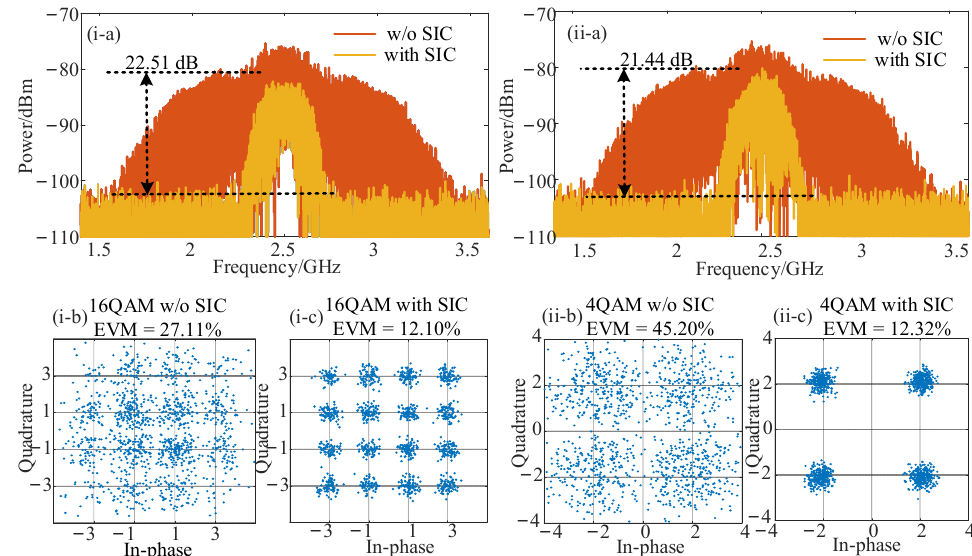
Figure 5. The SOI recovery performance for harmonic down-conversion when a 2 GHz SI signal and a 500 MHz SOI centered at 20.5 GHz with the modulation formats of ( i ) 16-QAM and ( ii ) 4-QAM were used. ( a ) The measured electrical spectra with and without SIC, the measured EVM ( b ) without and ( c ) with SIC.